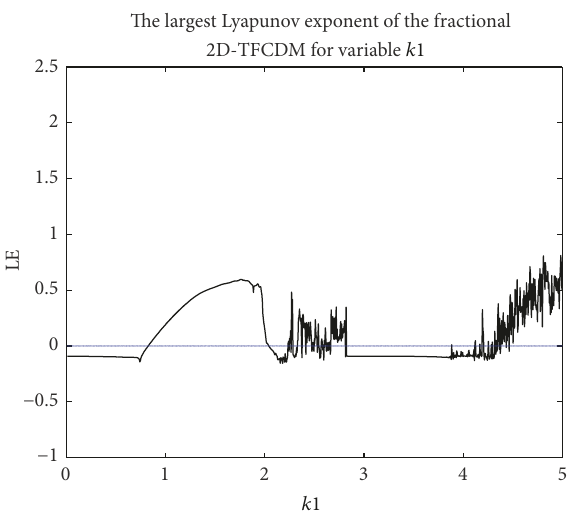
Figure 4: The largest Lyapunov exponent of the fractional 2D-TFCDM of the variable 𝑘 1 .